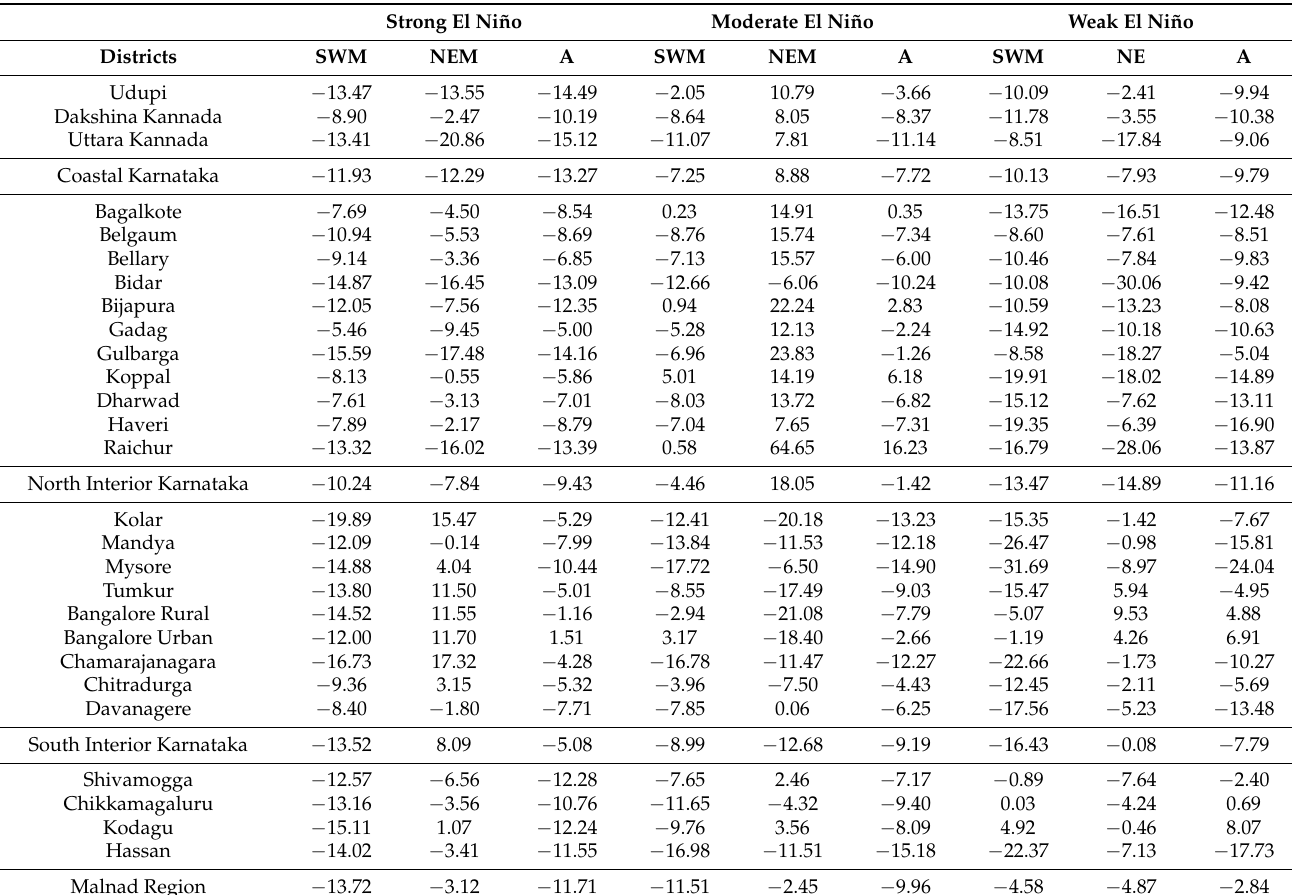
Table 3. District-wise percent change in seasonal and annual rainfall during El Niño years compared to normal years (1950–2018). Strong El Niño Moderate El Niño Weak El